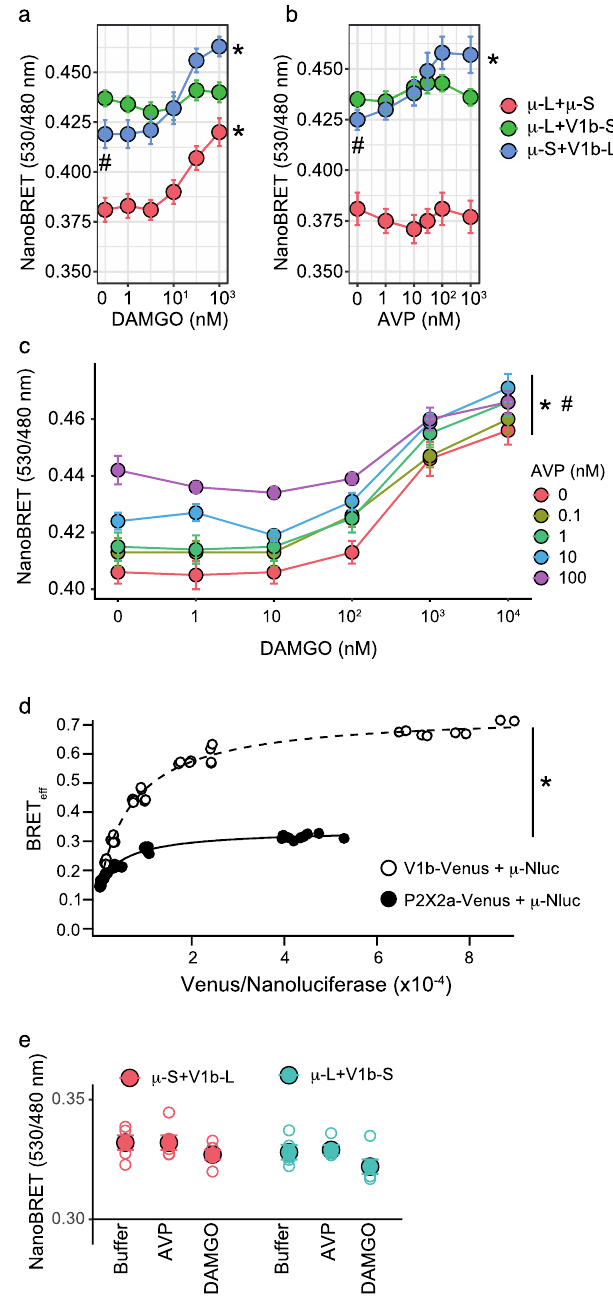
Figure 2. Agonists for μ and V1b receptors stimulated the access of β-arrestin 2 to μ-V1b receptors. NanoBit components, LgBit (L) and SmBit (S), were fused to the μ and V1b receptors. Plasmid DNAs (0.75 μg for each receptor construct) were coexpressed in HEK cells together with 3 μg of β-arrestin 2-Venus and the cells were stimulated with the indicated concentrations of ( a ) DAMGO (n = 8), ( b ) AVP (n = 6–7) and ( c ) DAMGO plus AVP (n = 6). In ( c ), V1b-LgBit and μ-SmBit were used. *in ( a , b ) indicates a significant increase in the NanoBRET from the lowest agonist concentration ( p < 0.05). # in (a) and ( b ) indicates a significant increase in the basal NanoBRET signal intensity ( p < 0.05). *and # in ( c ) indicate that AVP and DAMGO were significant determinants of the NanoBRET values ( p < 0.05). ( d ) A reduction of donor luminescence increased the NanoBRET signal in μ-V1b receptors. HEK cells were cotransfected with V1b-Venus (open circle) or P2X2a-Venus (closed circle) together with μ-Nluc at different ratios (1:0.08–39). The NanoBRET values, the fluorescence at 530 nm, and the luminescence at 480 nm, were measured. For BRET max , Venus and Nluc were sequentially fused to the C-terminus of the μ-receptor. The μ-Venus-Nluc construct was expressed in HEK cells, and NanoBRET signals were measured without agonist stimulation. The NanoBRET efficiency (BRET eff ) was calculated as BRET/ BRET max28 . Representative data from a single experiment are shown. Experiments were repeated three times and yielded similar results. *indicates that the transfected plasmids were significant determinants of BRET eff values ( p < 0.05). ( e ) Agonists did not change the luminescence of the split Nanoluciferase, which was fused to the μ-V1b receptors. μ-LgBit + V1b-SmBit or μ-SmBit + V1b-LgBit was expressed in HEK cells and the luminescence was measured in the presence of buffer, 100 nM AVP or 100 nM DAMGO. The NanoBRET ratio at 530/480 nm was calculated. The statistical computer program R version 4.0.3 (R Core Team, [2020], Vienna, Austria. https:// www.r- proje ct. org) was used to prepare Fig.